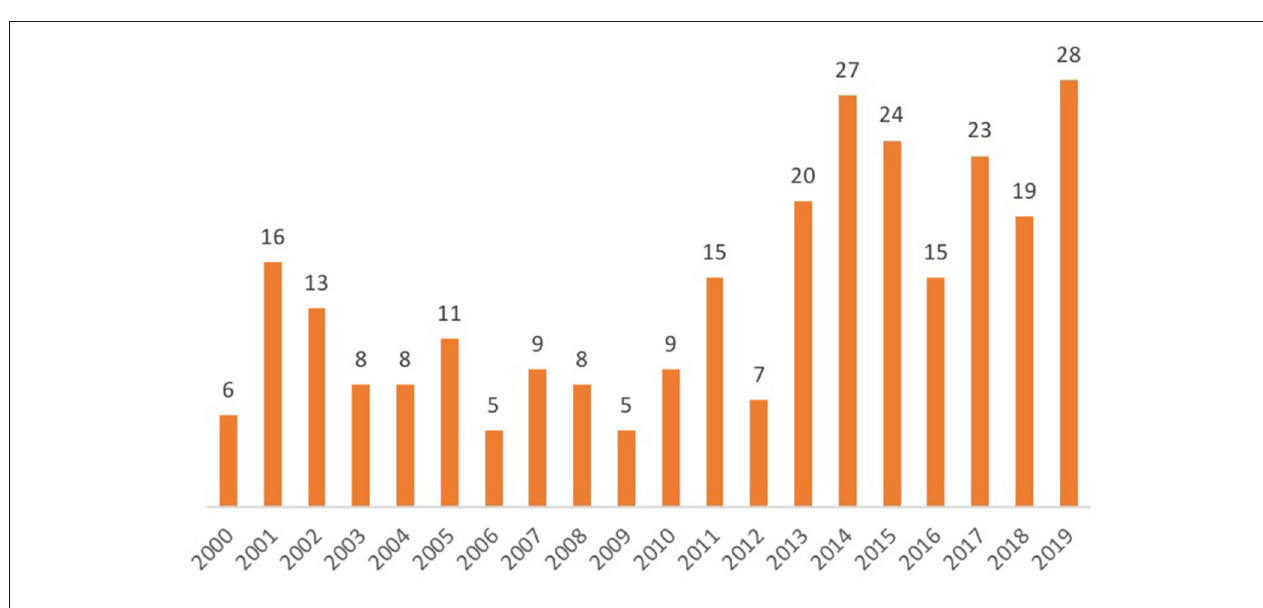
FIGURE 2 | Number of studies, by